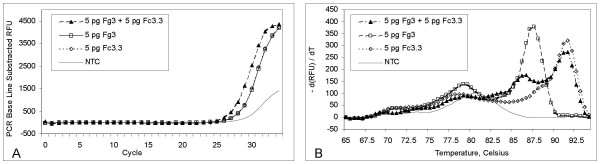
Progress and melting curves of PCR products used for the detection of F. culmorum and F. graminearum. PCR and melting curve analysis was performed in a real-time thermocycler with primer pairs specific for F. culmorum and F. graminearum and SYBR Green I fluorescence detection as described in the Methods. The SYBR Green I was diluted to 0.4× the recommended concentration. Genomic DNA from F. graminearum (continuous curves with squares), F. culmorum (dotted curves with diamonds), a mixture containing DNA from both species (dashed curves with triangles) and no DNA (no-template control, "NTC ", gray curve without symbols) were used as templates. A: Progress curves, showing the fluorescence signal during the annealing phase in each reaction cycle. B: Melting curves recorded on PCR products after 35 cycles. The rise of fluorescence in the no-template control produces a melting point maximum at about 80°C, far lower than where Fusarium target are detected. Because melting curves presented in Figure 1B were recorded with low template amounts, the unspecific products are also visible, but they do not prevent the detection of Fusarium DNA in amounts equal to or higher than the limit of detection.